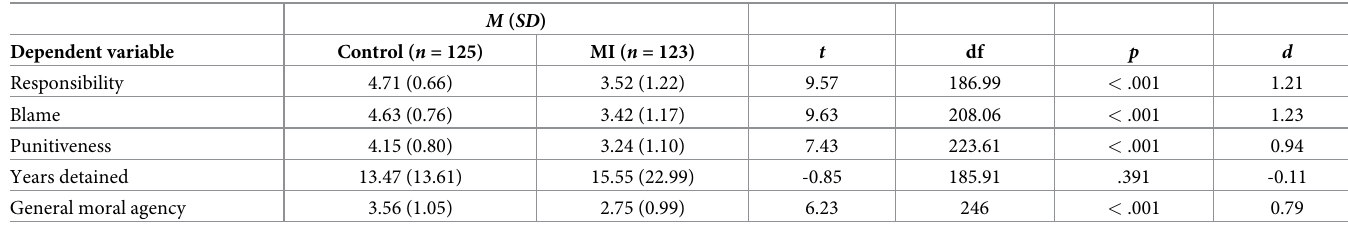
Table 4. Descriptive and t-test statistics for dependent variables at trial (Study 2).